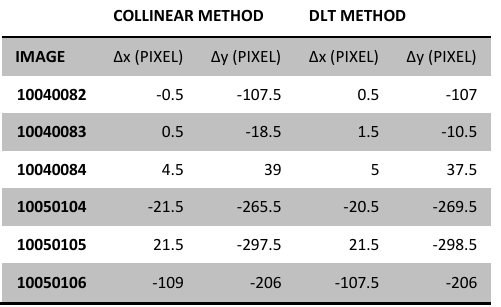
Table 2: Mismatch values in X and Y directions for digital